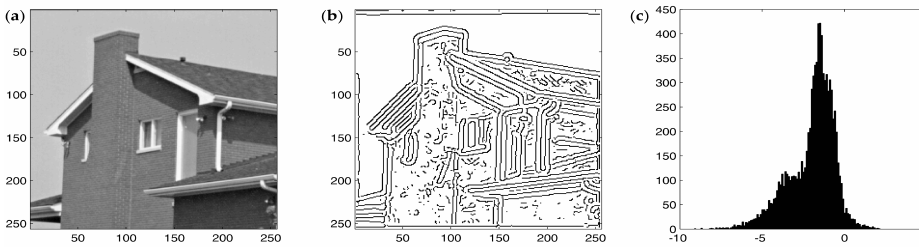
Figure 7. ( a ) Original House image, ( b ) modulus maxima after thresholding, ( c ) histogram of Lipschitz exponents correspond to maxima lines in ( b